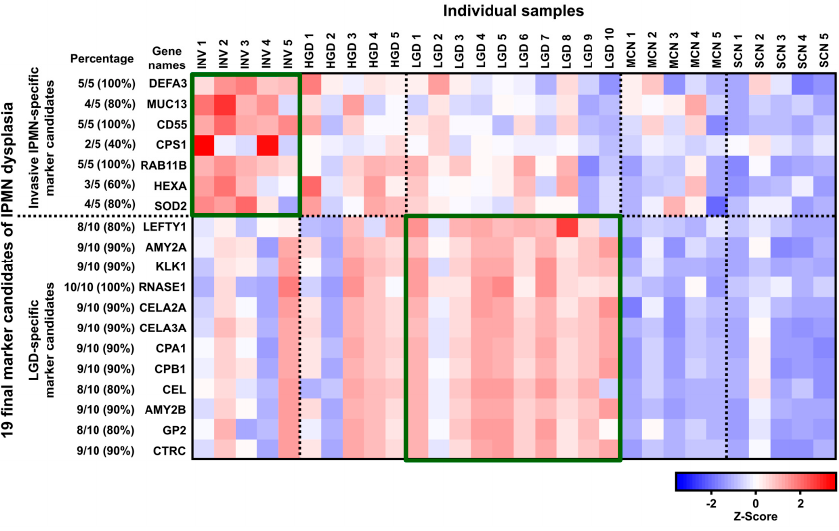
Figure 4. Overview of protein expression of the 19 final marker candidates of IPMN dysplasia. The heat map represents the expression patterns of the 19 final potential markers of IPMN dysplasia, based on z-score. Z-scores were calculated by averaging the LFQ intensities of the 3 technical replicates of each biological replicate. Red and blue reflect positive and negative values, respectively. Seven invasive IPMN-specific marker candidates were highly expressed in invasive IPMN. In contrast, 12 LGD-specific marker candidates were predominantly expressed in LGD. The percentage reflects the proportion of the 5 invasive IPMN samples showed upregulation of the given protein. Similarly, the percentage of LGD-specific marker candidates represents the number of LGD samples that showed upregulation for the given protein.